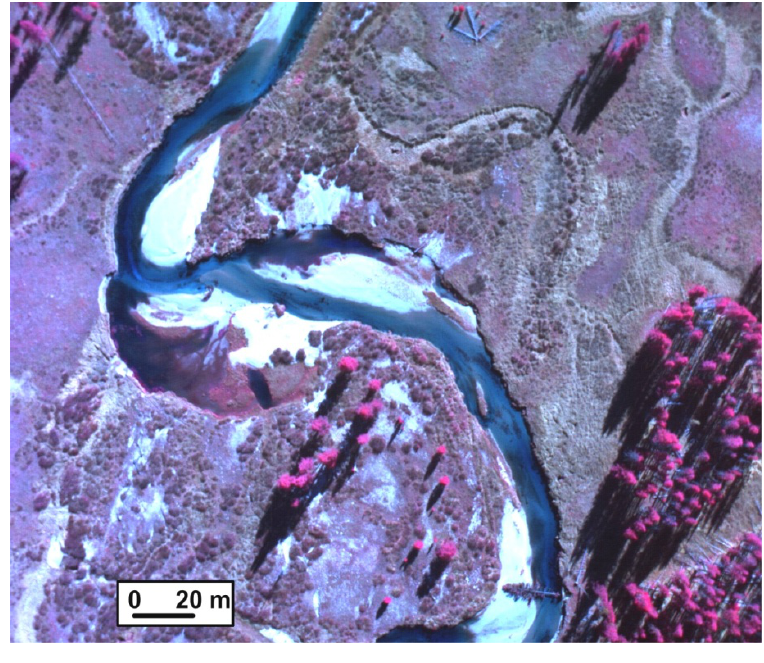
Figure 3. CIR digital imagery from Elk Creek, tributary to the upper Middle Fork Salmon River, ID, USA. Pixel resolution is about 15